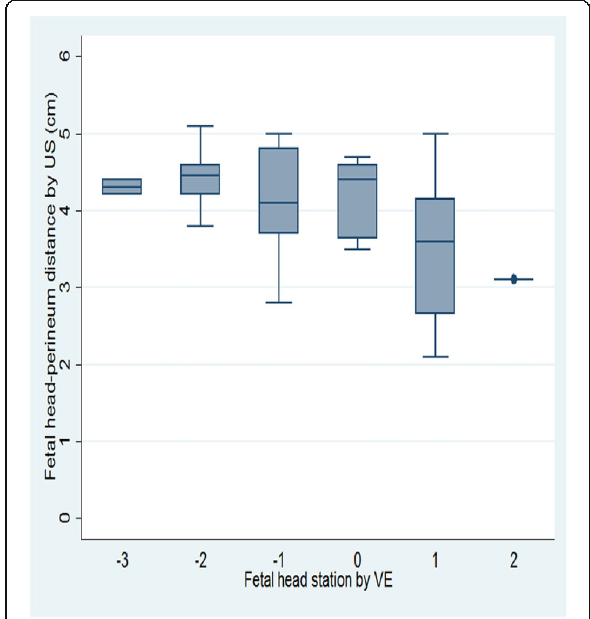
Fig. 9 Box plot showing relation between fetal head station by VE and fetal HPD by US. Box plot showing the relation between the fetal head station by VE and fetal head-perineum distance by US. The box represents the range from the first quartile to the third quartile (interquartile range). The line inside the box represents the median (second quartile). Error bars represent the minimum and